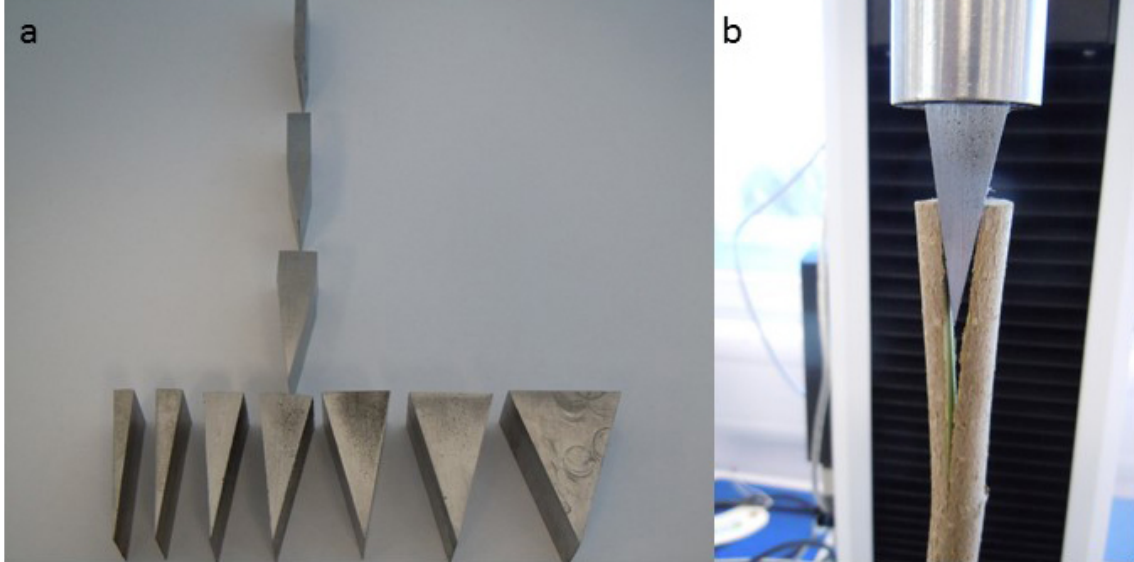
Figure 5. a) The wedges used to split the coppice, with angles of 7, 10, 15, 20, 25, 30 and 40 degrees, while the 20 degree wedge was used with widths of 3.5, 7,1 and 10.6 mm. b) Splitting of a coppice pole by the 20 degree wedge. Note that the crack tip runs well ahead of the